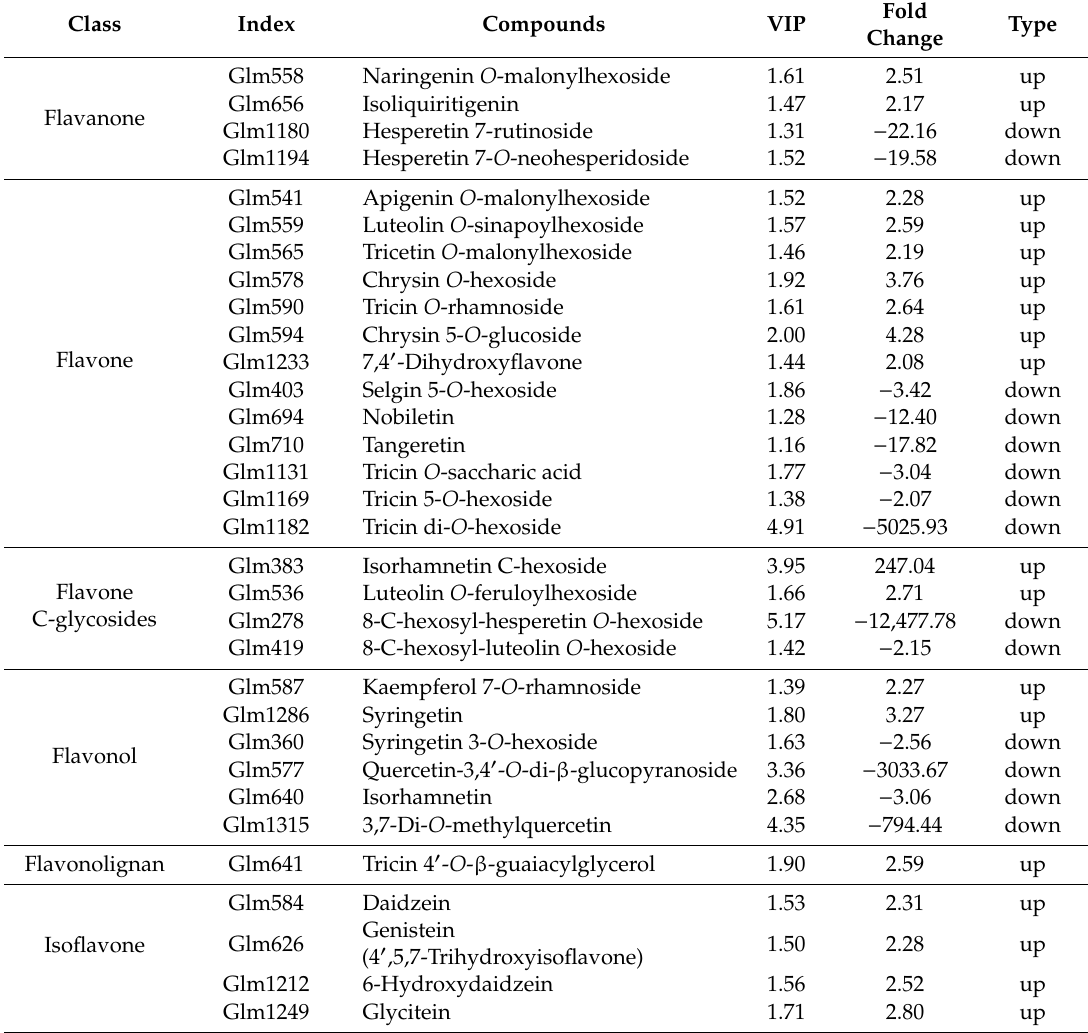
Table 1. Di ff erence of flavonoids in flower buds of NJCMS5A and NJCMS5B.